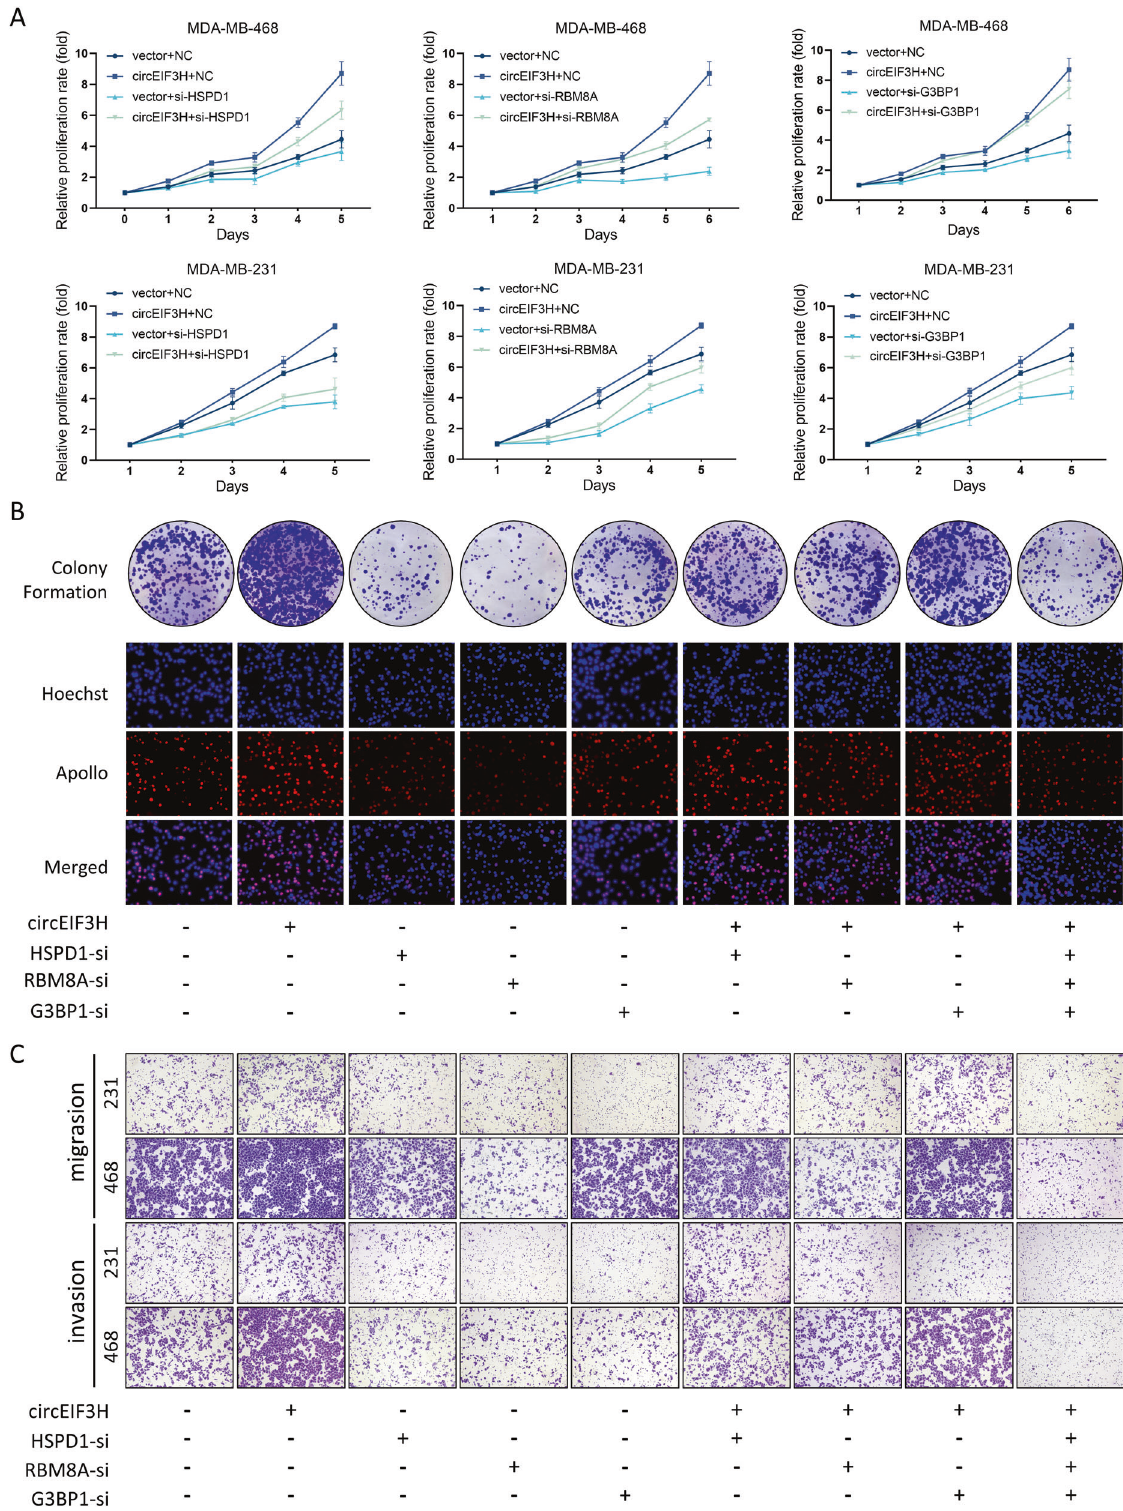
Fig. 5 HSPD1/RBM8A/G3BP1 silence rescues the cancer-promoting effect of circEIF3H. A – C TNBC cells transfected with pLCDH-ciR, circEIF3H, si-NC, or si- HSPD1/RBM8A/G3BP1 alone or simultaneously. Then the abilities of cell proliferation, colony formation, migration, and invasion were detected respectively, assessed by MTT ( A ), colony formation assay and EdU assay ( B ), transwell migration and matrigel invasion assay ( C ). The quantitative data were presented as mean ± SD. Statistical signi fi cance was determined by two-sided Student ’ s t -test, ** P < 0.01, *** P < 0.001. Cell experiments were repeated three